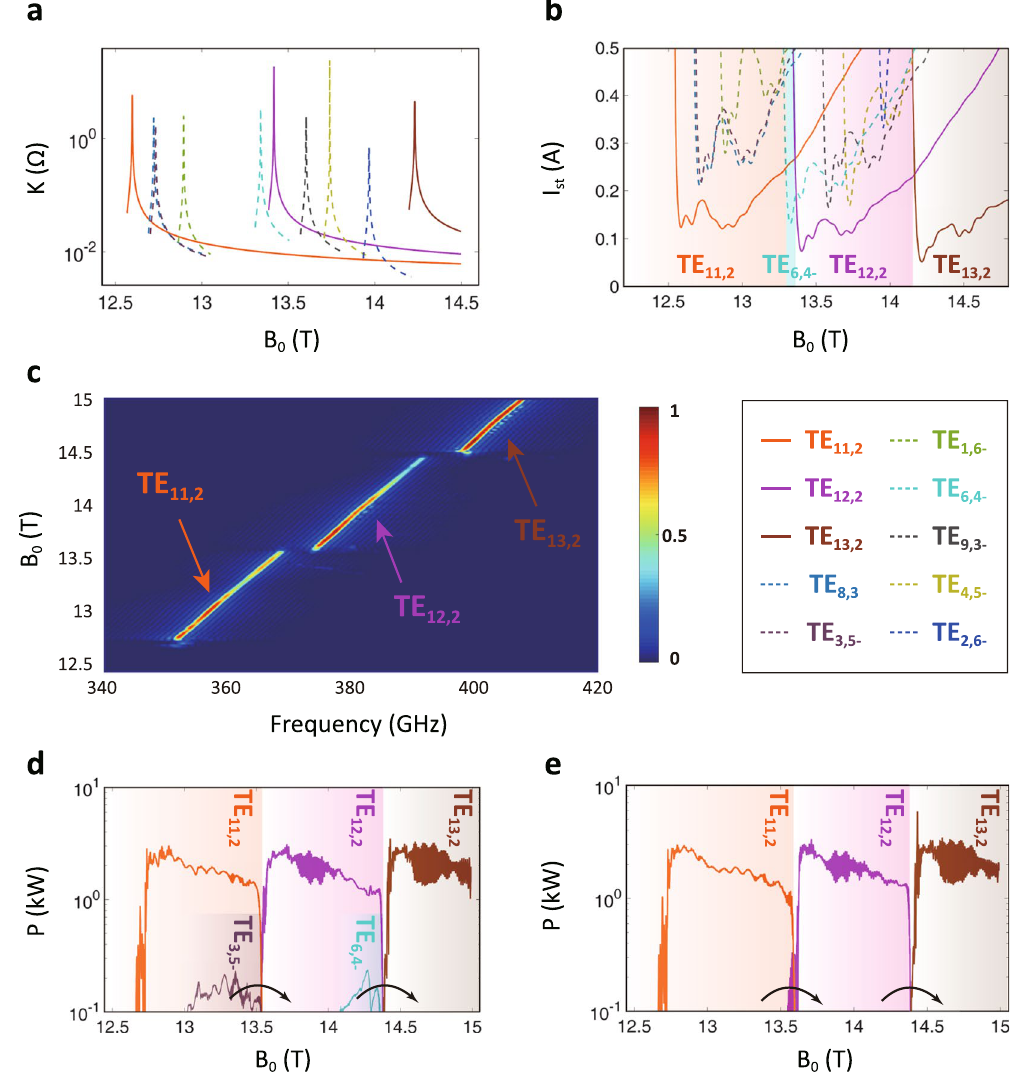
Figure 4. Multi-band radiation taking account of mode competition. ( a ) The beam-wave coupling impedances K of TE 11,2 , TE 12,2 and TE 13,2 modes in solid lines, as well as internal threatening competing modes in dashed lines. The counter-rotating mode is with a minus while the co-rotating mode has no specific sign. ( b ) The start-oscillation current curves of TE 11,2 , TE 12,2 and TE 13,2 modes, as well as internal competing modes. ( c ) The frequency spectrum and ( d ) output power generated by TE 11,2 , TE 12,2 and TE 13,2 modes and internal competing modes. ( e ) The output power of TE 11,2 , TE 12,2 and TE 13,2 modes without mode competition. It takes the same magnetic field sweeping rate as that in competition